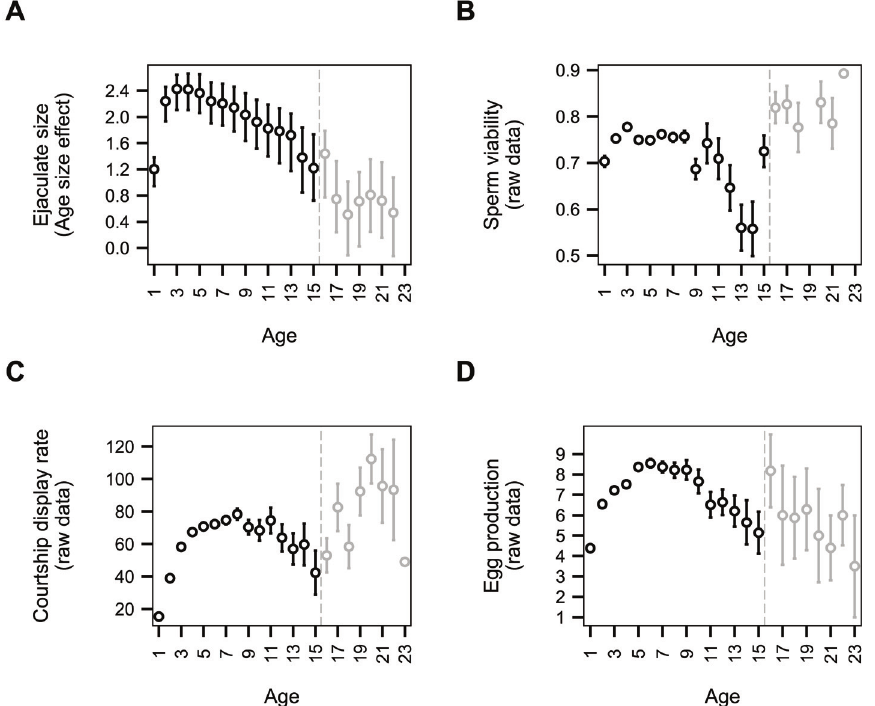
Fig 1. Age-related variation of houbara bustard reproductive traits. As ejaculate size (A) measures were intra-annually repeated raw data cannot be used to assess age-related variation. Age-related size effect was estimates using mixed model on phenotypical data (see Material and method and Results; posterior mode ± Credible Interval). For Courtship display rate (B), Egg production (C) and Sperm viability (D), raw data were plotted (mean ± SE). All traits showed phenotypic senescence (see Results). The ages in grey were not included into analyses.